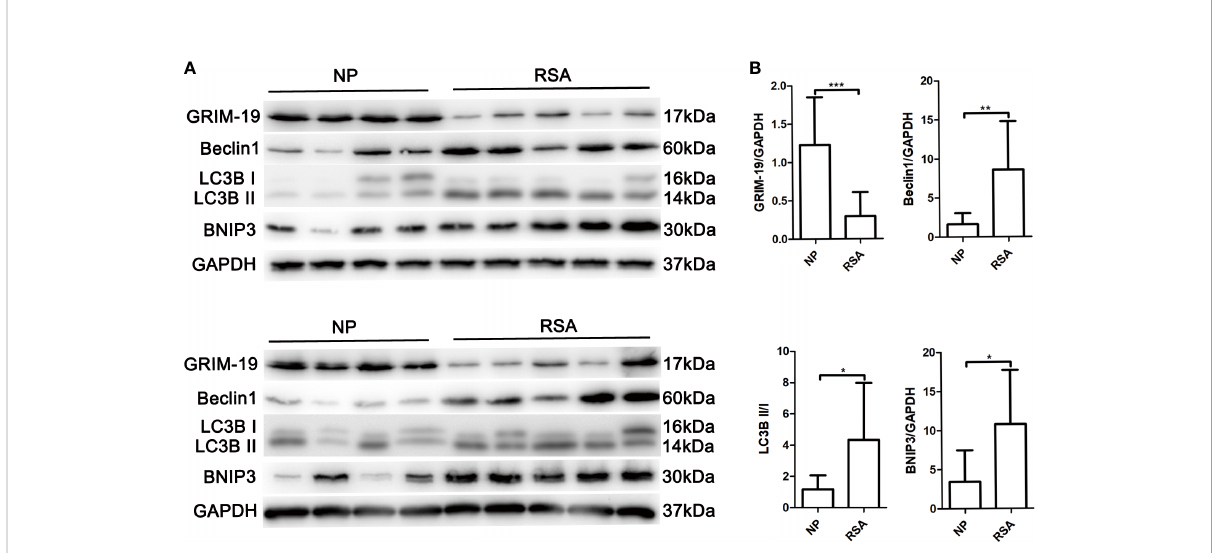
FIGURE 1 Determination of Grim-19 expression in decidual macrophages of RSA patients and the NP group, and the expression of autophagy related proteins. (A) The expression of Grim-19, Beclin1, LC3B II/I and BNIP3 in decidual macrophages of RSA patients (n = 10) and the NP group (n = 8) was examined through western blot analysis. GAPDH served as a loading control. (B) Quanti fi cation of Grim-19, Beclin1, LC3B II/I and BNIP3 expression through relative densities. Data are shown as the mean ± SD. *** p < 0.001, ** p < 0.01, * p <